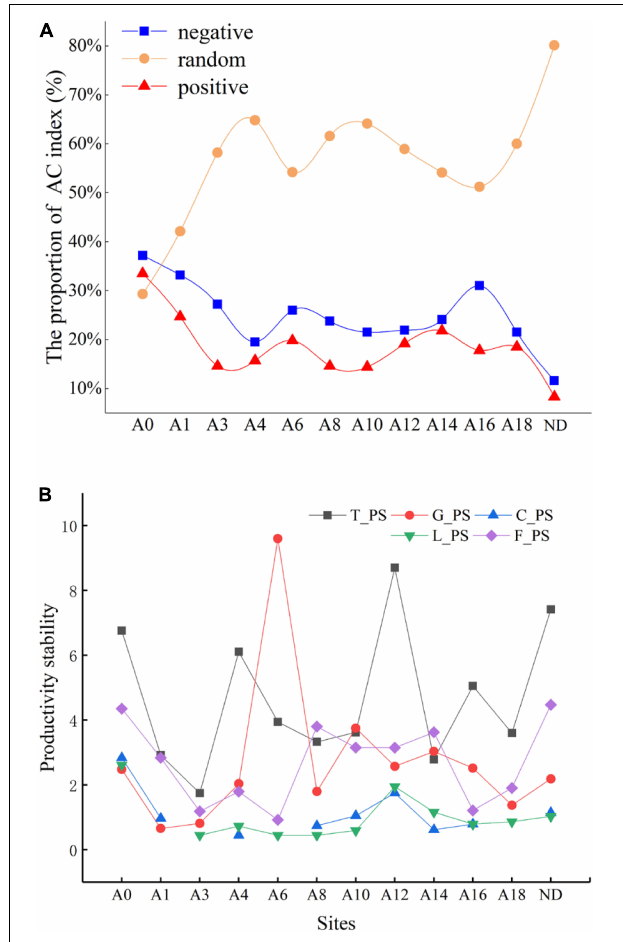
FIGURE 2 | Changes in the proportion of inter-specific associations of the plant community (A) and stability index of artificial grassland productivity (B) in different years of construction. T_PS, G_PS, C_PS, L_PS, and F_PS, respectively, represent the stability of the total community, Grass stability, Cyperaceae stability, Leguminosae stability, and Forb stability. The number after the letter “A” indicates the restoration period of artificial grassland, A0 represents “black beach” and ND represents a non-degraded healthy alpine meadow.